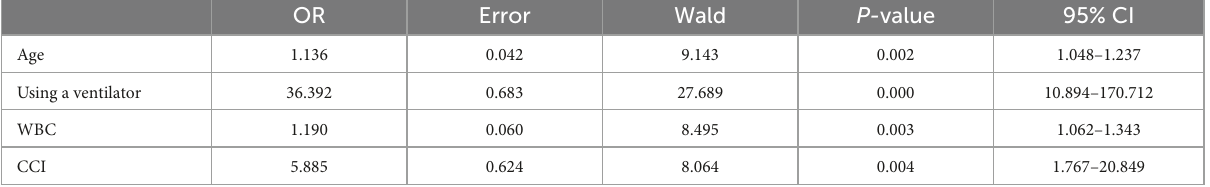
TABLE 2 Significant predictors of 6-month unfavorable outcome of patients with aSAH treated by endovascular coiling.